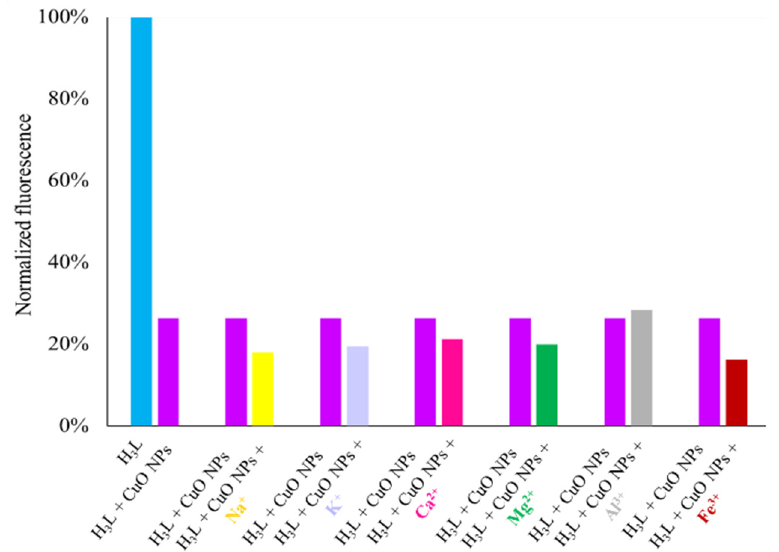
Figure 14. Fluorescence responses of H 3 L (2.5 nM, 1.26 ppb) toward CuO NPs (8 ppm) in the presence of some common metal ions (top) such as Na + (8 ppm), K + (8 ppm), Mg 2+ (8 ppm), Ca 2+ (8 ppm), Fe 3+ (8 ppm), and Al 3+ (4 ppm). All experiments were performed in 4 mL of an ethanol–water solution in 80:20 v/v (pH 11) under λ exc = 400 nm.